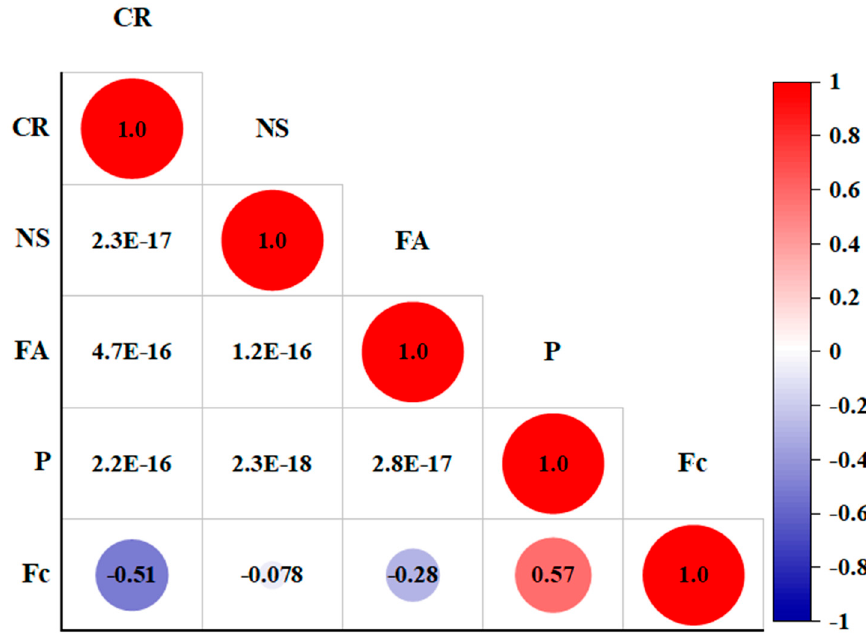
Table 5. Descriptive statistic of the experimental dataset.